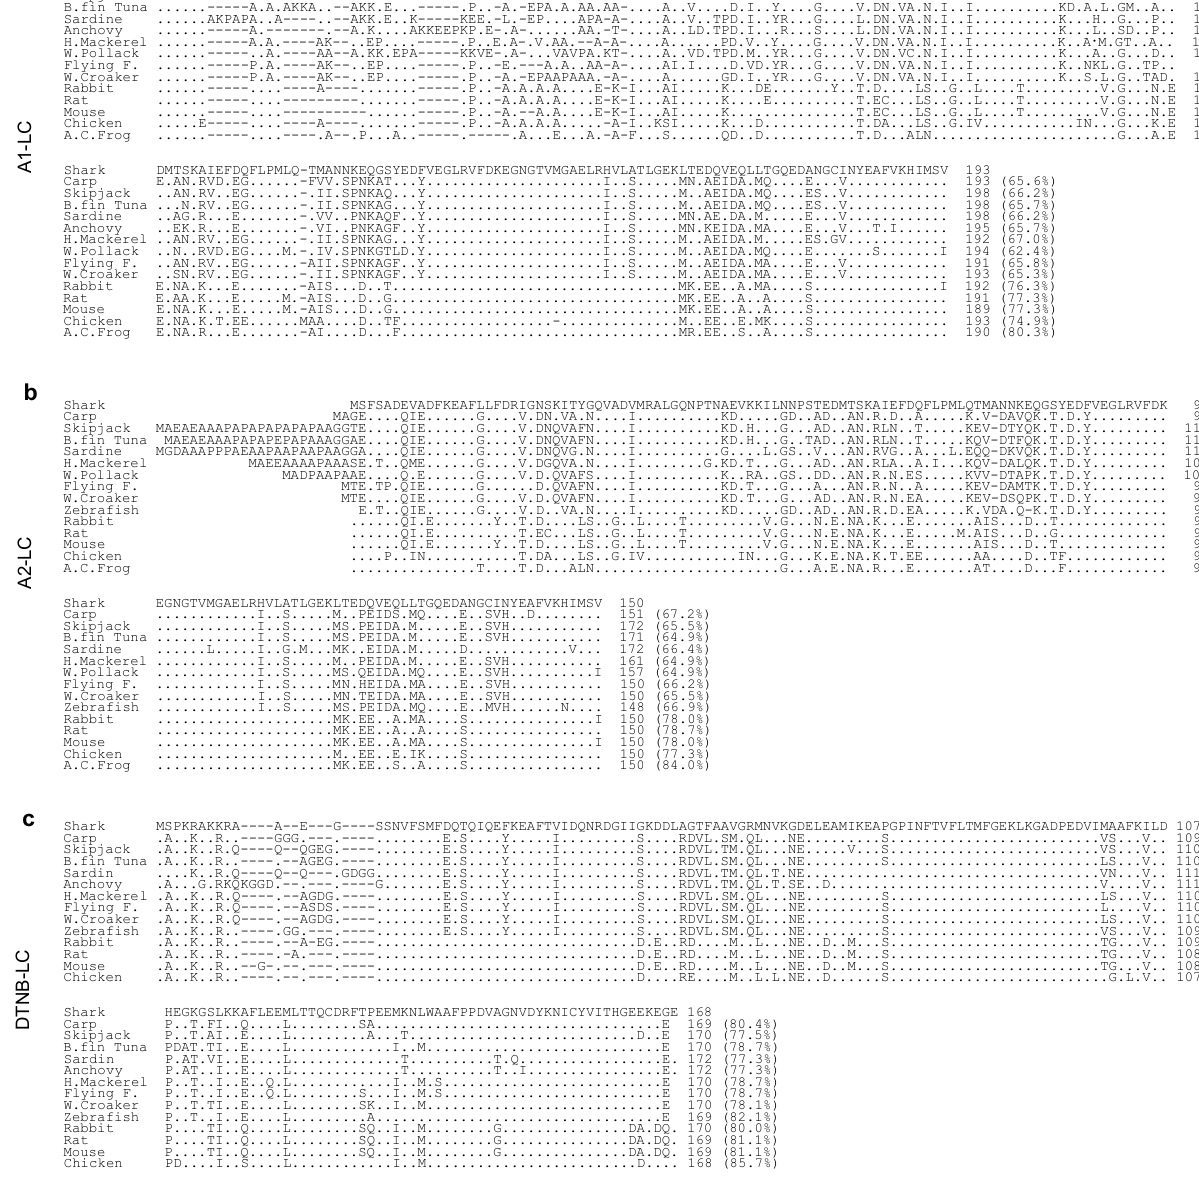
Figure 2. Multiple sequence alignment of the banded houndshark Triakis scyllium myosin light chains amino acid sequences determined in this study to those from other species. ( a ) A1 light chain, ( b ) A2 light chain, ( c ) DTNB light chain. Sequences for comparison were obtained from the DNA Data Bank of Japan: carp Cyprinus carpio , skipjack tuna Katsuwonus pelamis , bluefin tuna Thunnus orientalis , sardine Sardinops melanostictus , anchovy Engraulis japonica , horse mackerel Trachurus japonicus , walleye pollack Gadus chalcogramma , flying fish Cypselurus agoo , white croaker Pennahia argentata , zebrafish Danio rerio, rabbit Oryctolagus cuniculus , rat Rattus norvegicus , mouse Mus musculus , chicken Gallus gallus and African clawed frog Xenopus laevis . The numbers on the right side represent the amino acid sequence from the N-terminus. Gaps were inserted to optimize the sequence alignment. Dots indicate identical amino acid residues to those of shark myosin light chain. Percent sequence identities between shark myosin light chain and the other sequences are given in